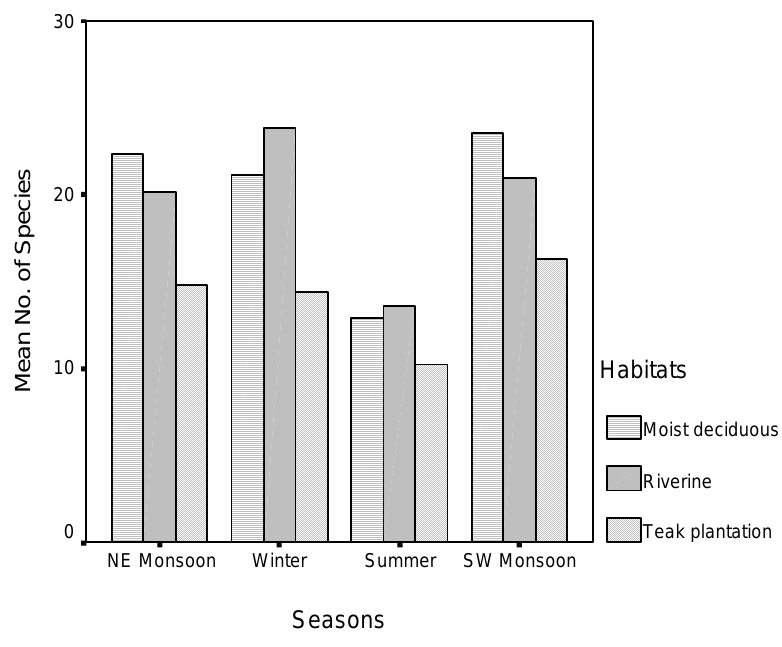
FIGURE 7. Mean species richness of